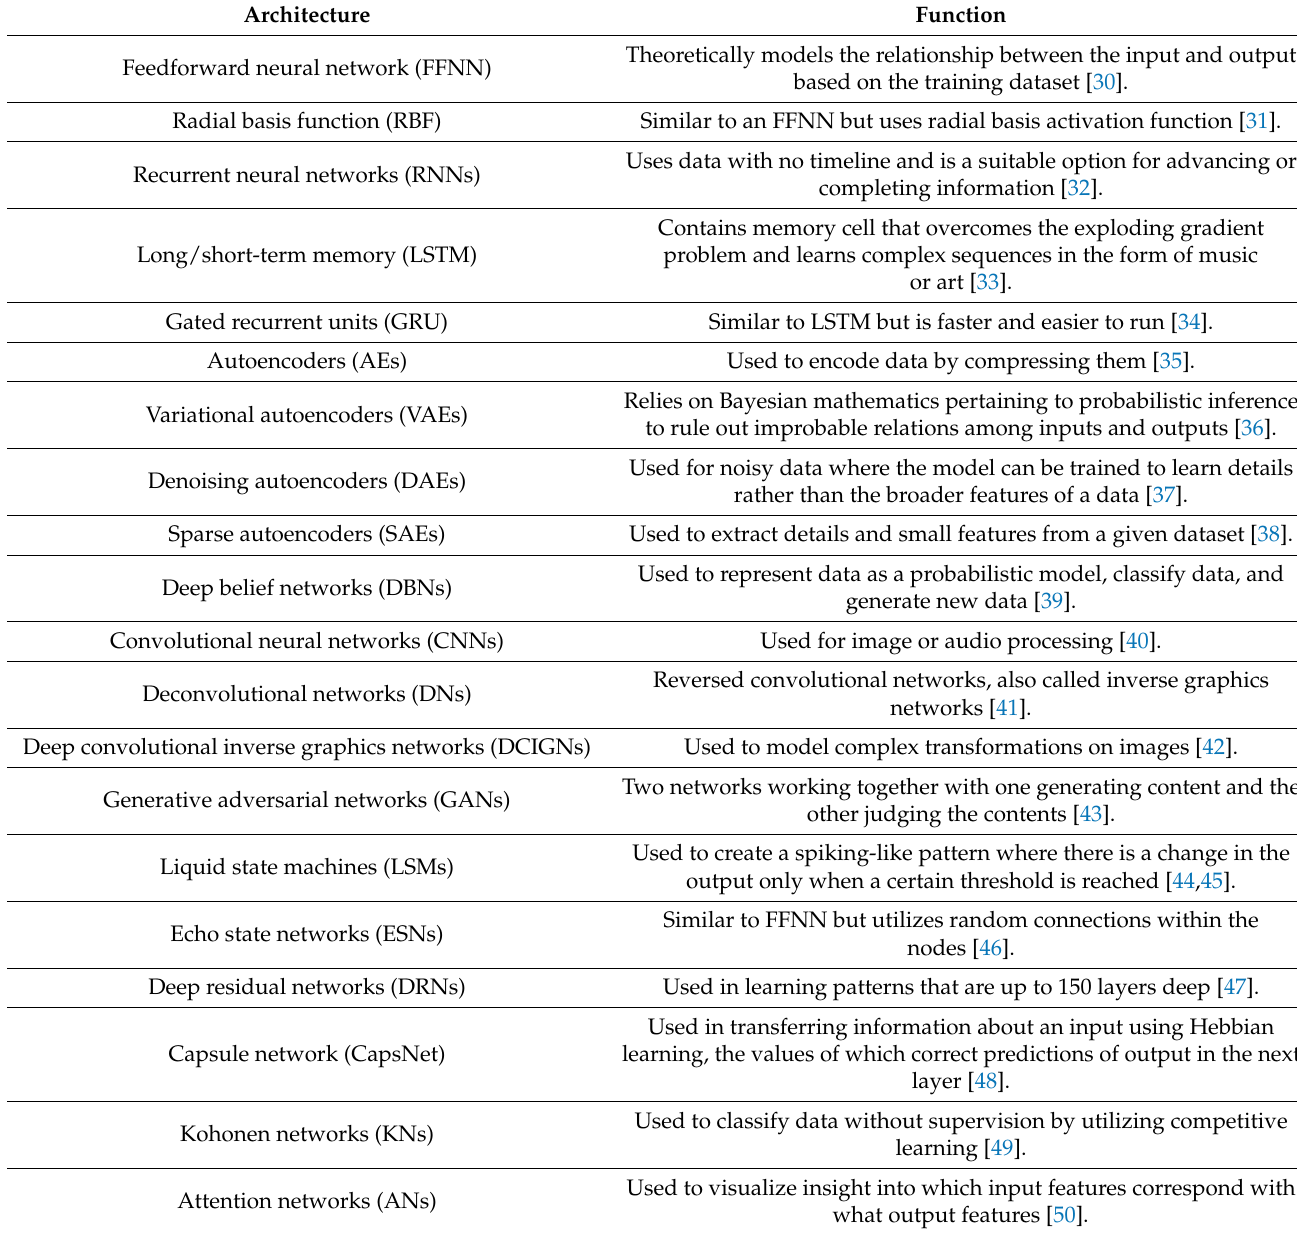
Table 5. Common ANN Architectures